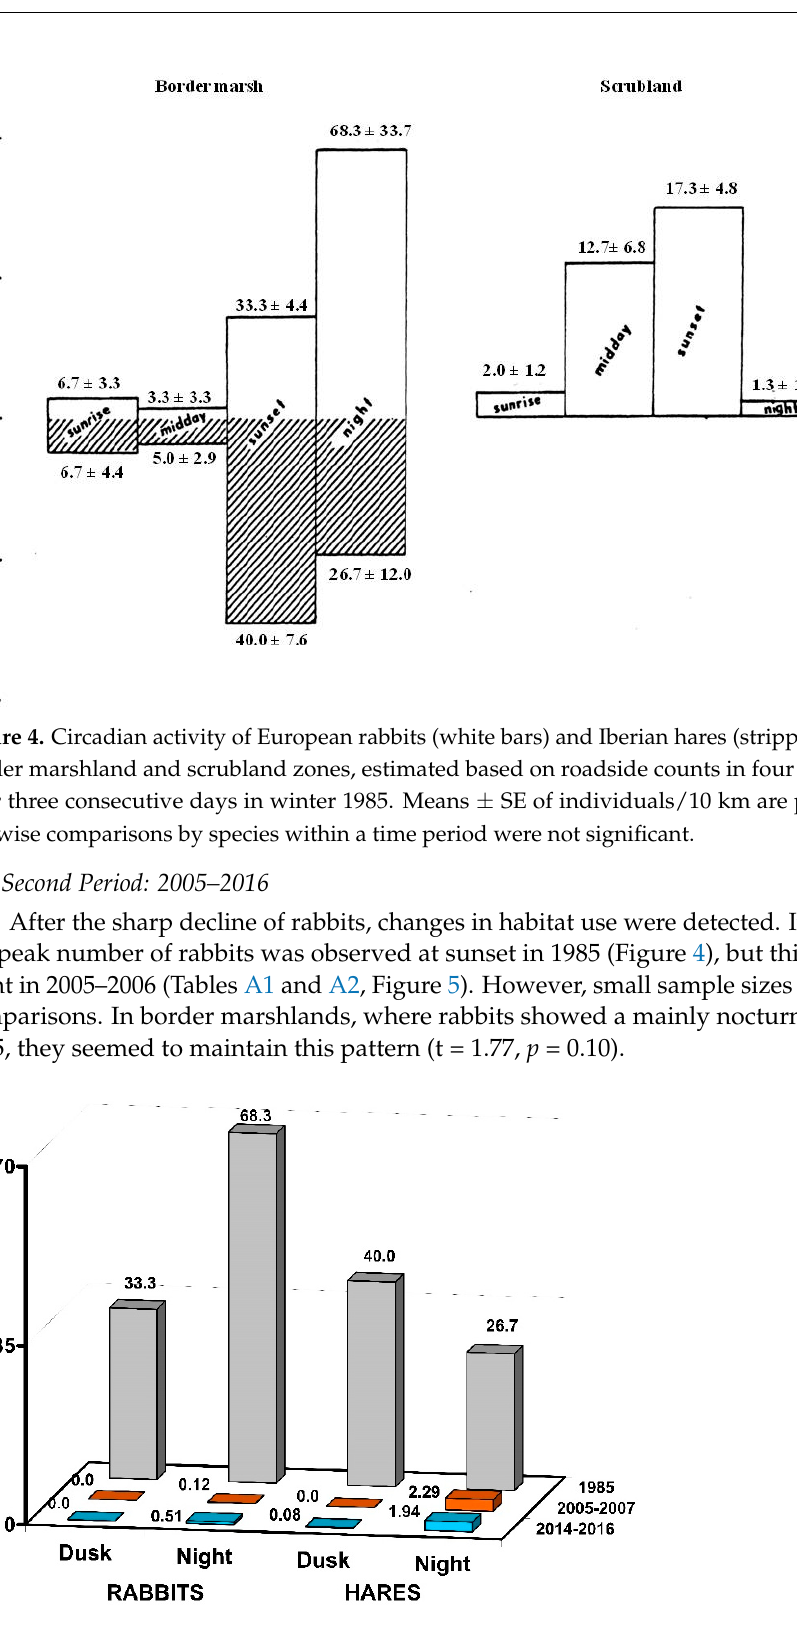
Figure 5. Abundances of European rabbits and Iberian hares in the border marshland during sunset and night, as estimated by roadside counts in the three intervals of study (data from 1985 are the same as in Figure 4; the rest of the data are from Tables A1 and A2). Note that, in spite of the two-order of magnitude drop in population numbers since 2005, rabbits have maintained the same pattern of activity (being mostly nocturnal in this habitat).